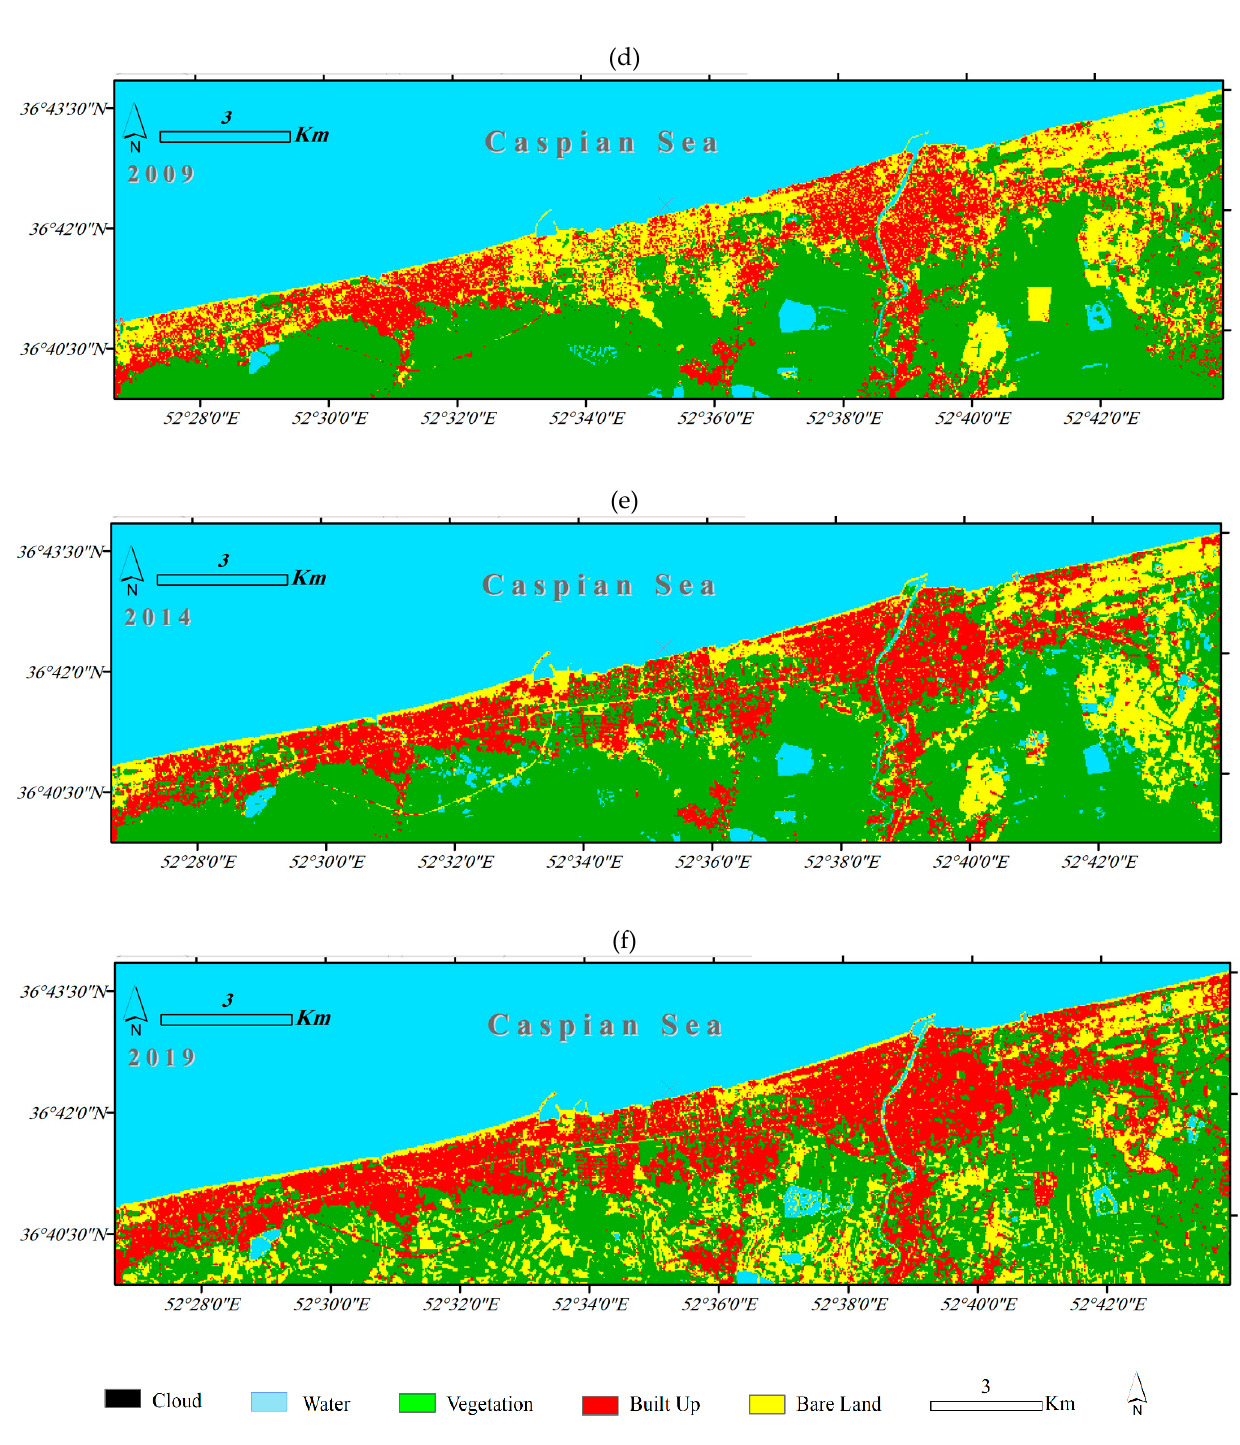
Figure 5. Land use/cover classes in the study area (1987–2019); ( a ): 1987, ( b ): 1993, ( c ): 1999, ( d ): 2009, ( e ): 2014, ( f ): 2019.